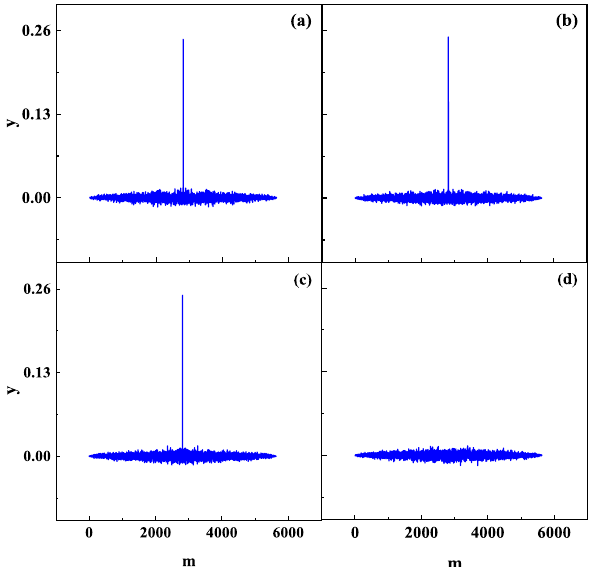
Figure 5. Correlation detection of encryption algorithm based on MTCNN. The autocorrelation function for ( a ) the chaotic sequence, ( b ) the ciphertext, ( c ) the plaintext; and ( d ) the cross-correlation function values of plaintext and ciphertext.